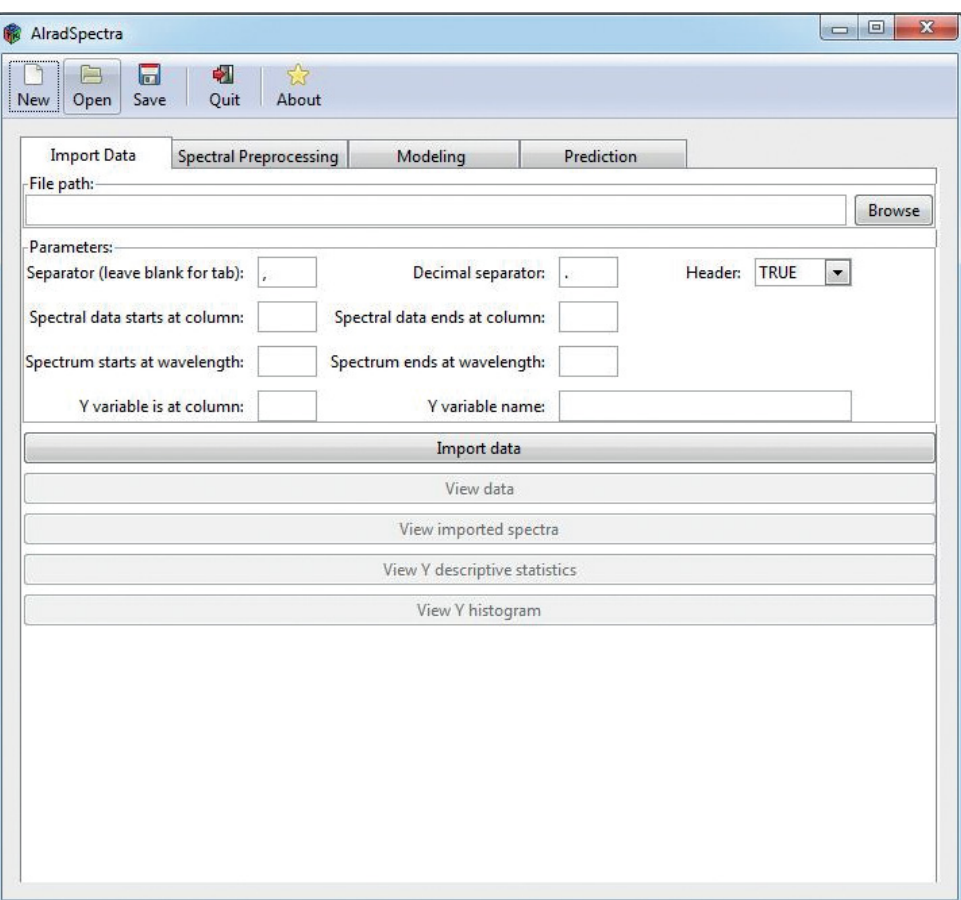
Figure 1. Graphical user interface of AlradSpectra showing the Import Data